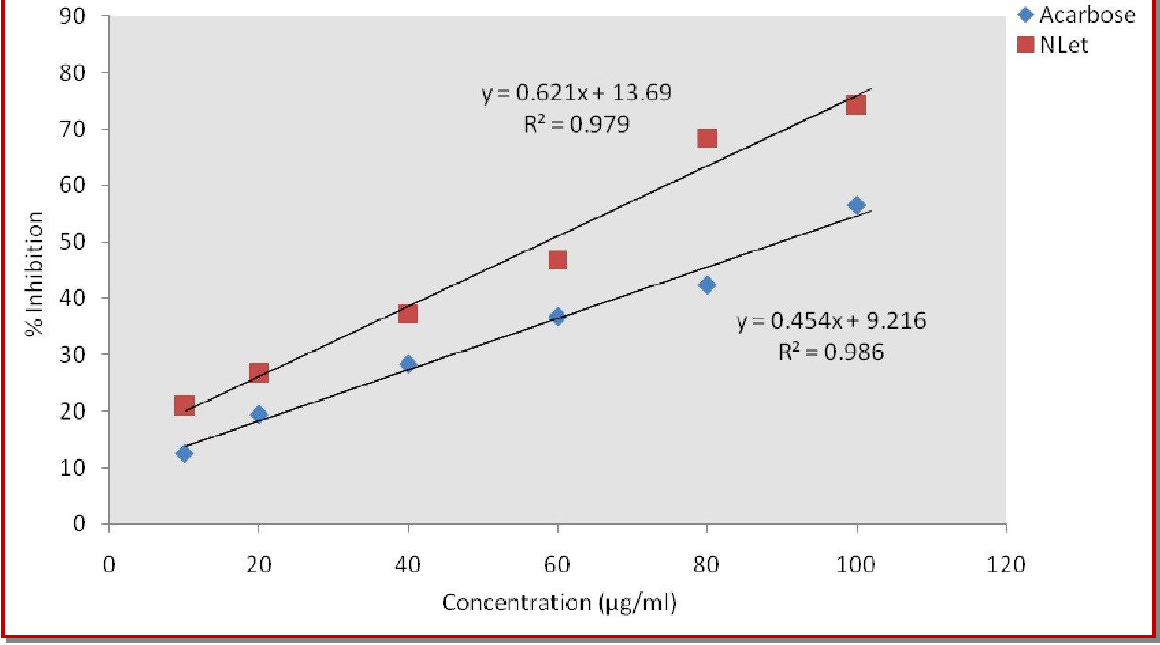
Figure 5: Inhibitory effect of N. laevis extract on rat pancreatic α - amylase Values represent mean ± SEM of three